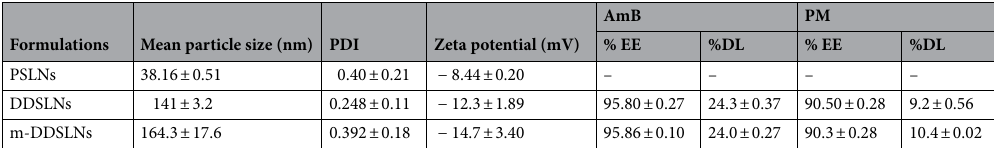
Table 1. Characteristics of PSLNs, DDSLNs and m-DDSLNs. Results are presented as mean ± standard deviation, (n = 3).